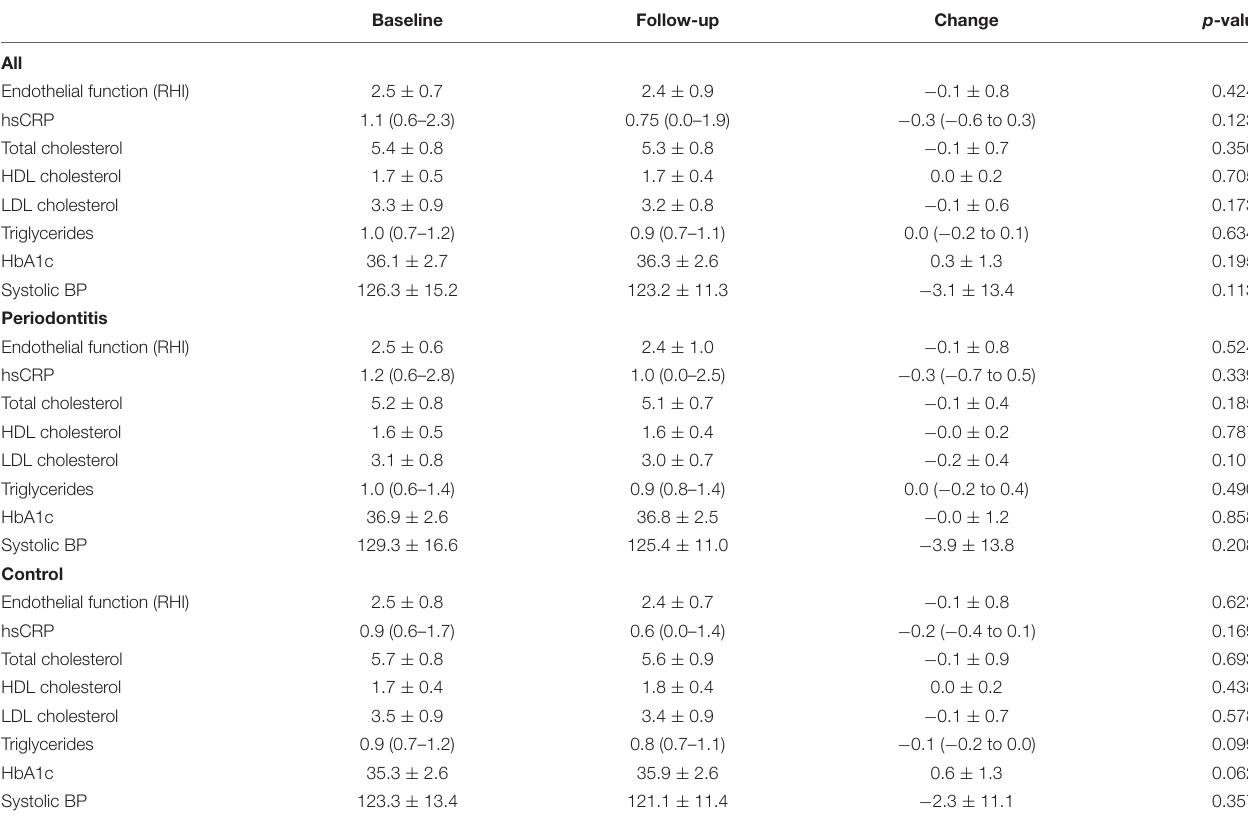
TABLE 3 | Changes in cardiovascular conditions. Baseline Follow-up Change p -value